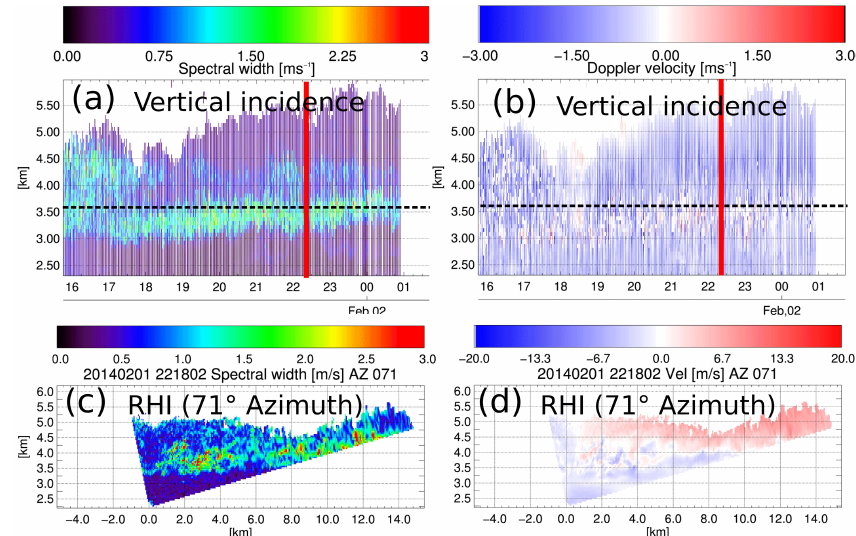
Figure 12. Time evolution of the vertical structure of Doppler-related variables during EV3. (a) Doppler spectral width at vertical incidence (ms − 1 ). (b) Mean Doppler velocity at vertical incidence (ms − 1 ), (c) RHI image of Doppler spectral width (ms − 1 ), and (d) RHI image of mean Doppler velocity (ms − 1 ). The horizontal black line in panels (a) and (b) indicates the altitude level of the JFJ site, while the vertical red line indicates the time of the RHIs in panels (c) and (d)